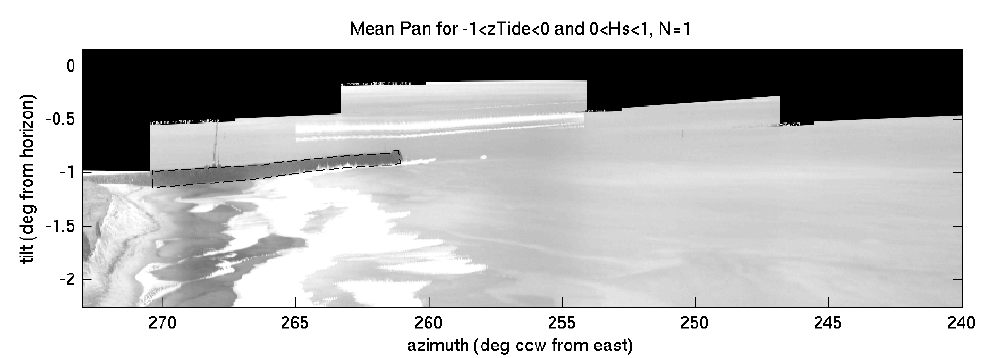
Figure 9. Averaged pan image for the lowest tides and lowest waves (only one image fit this condition). The jetty was manually digitized (dashed blue line) to define the region of interest for breaking detection. This region was then applied to pan images for all tide and wave height bins to detect the fraction that was obscured by breaking